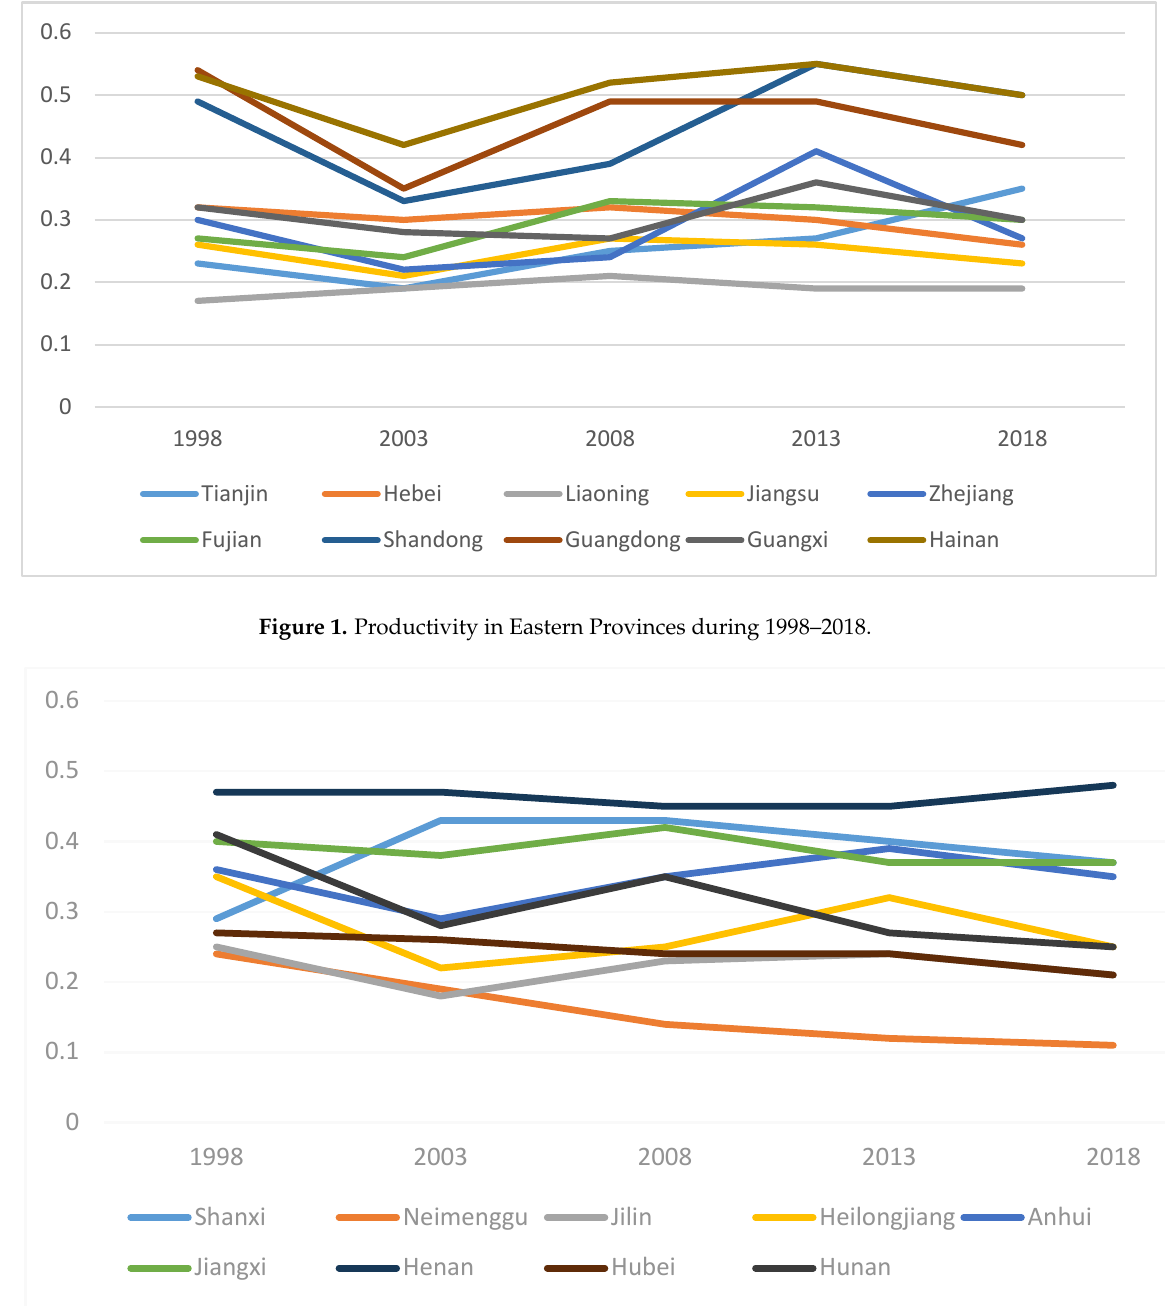
Figure 2. Productivity in Central Provinces 1998 – 2018.